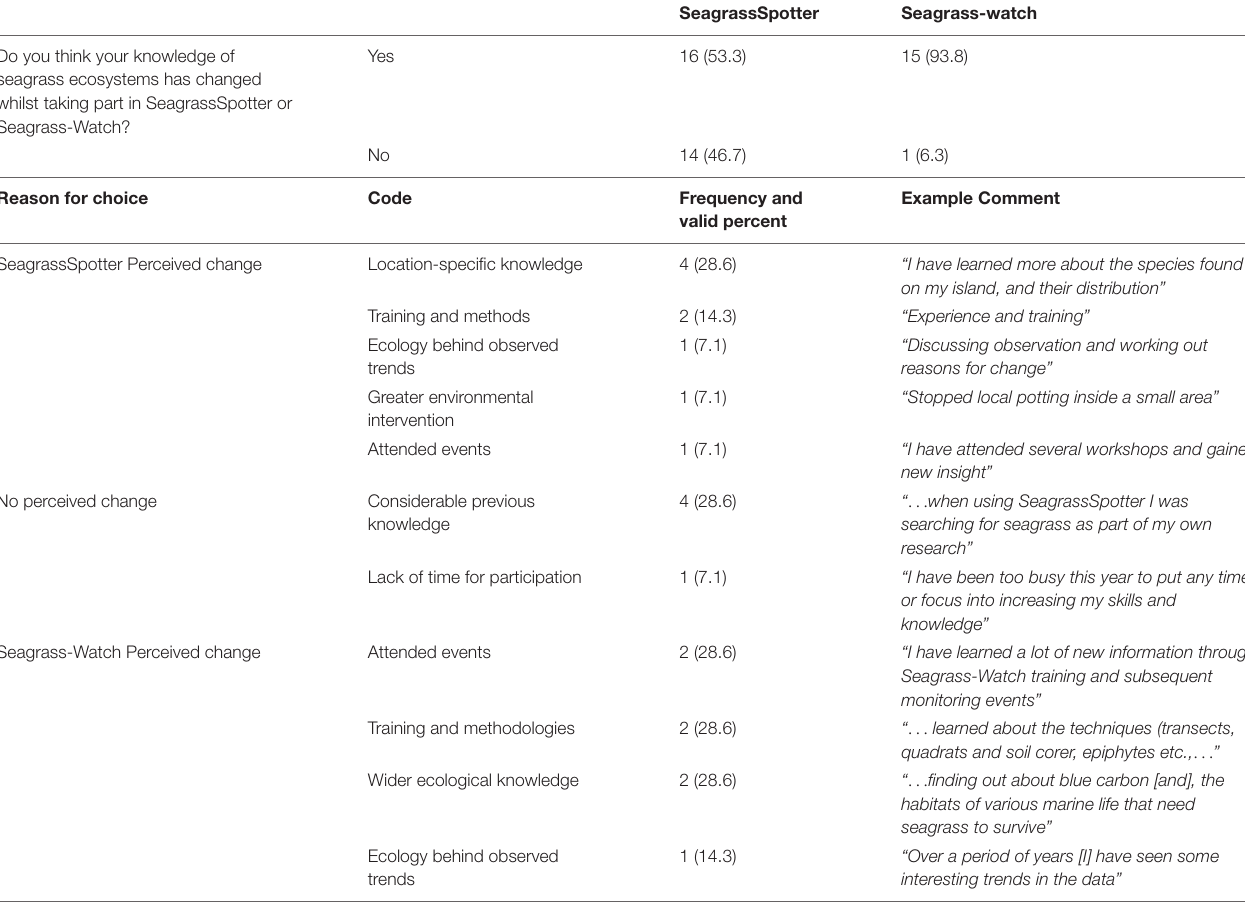
SeagrassSpotter Seagrass-watch